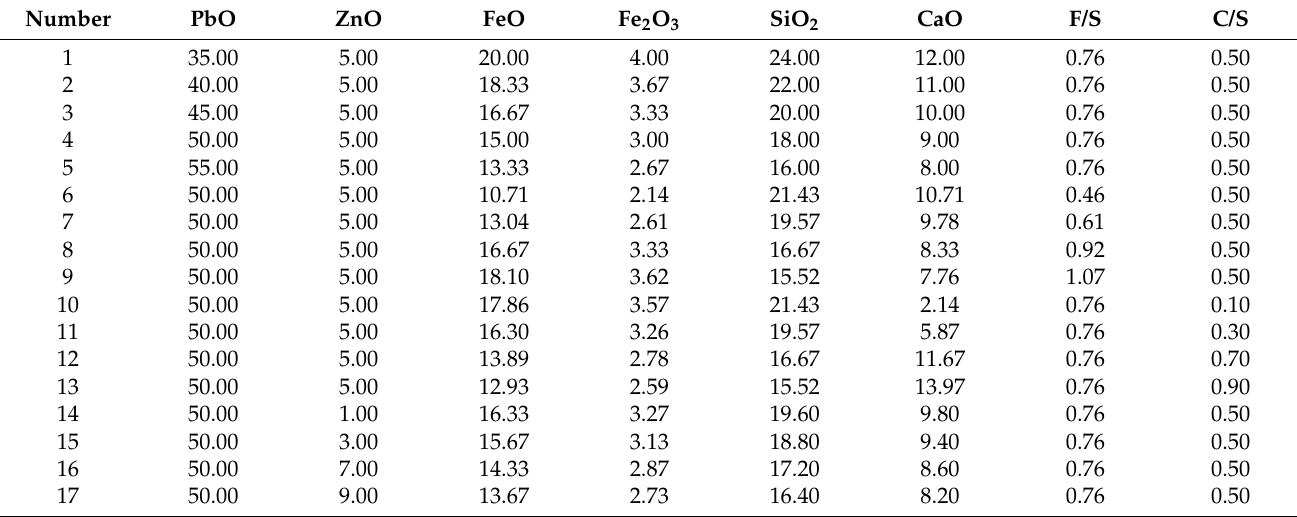
Table 4. Composition of the designed slag type (mass